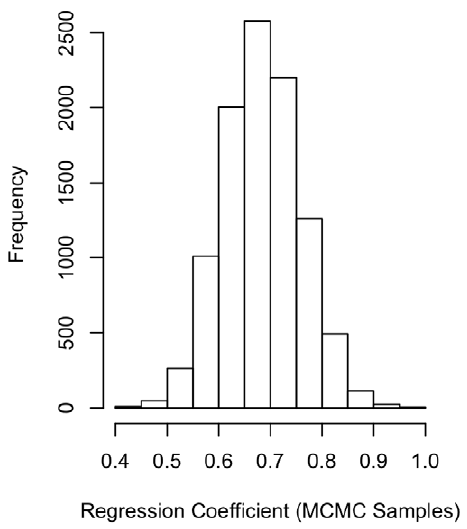
Figure 2. Regression of number of males on number of females. The distribution of regression coefficients was obtained from the MCMC analysis. Note that all coefficients sampled are substantially larger than zero, providing strong support for an association between these two variables.